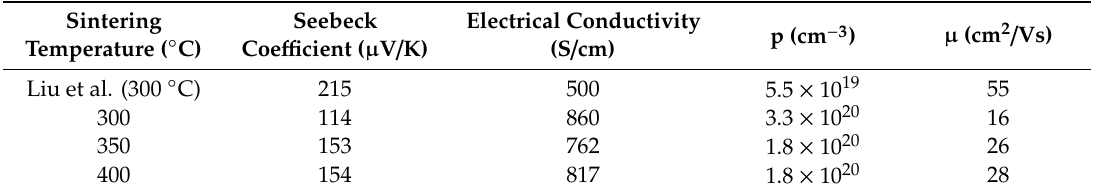
Table 4. Carrier concentration and mobility calculations at room temperature for the sintering temperature